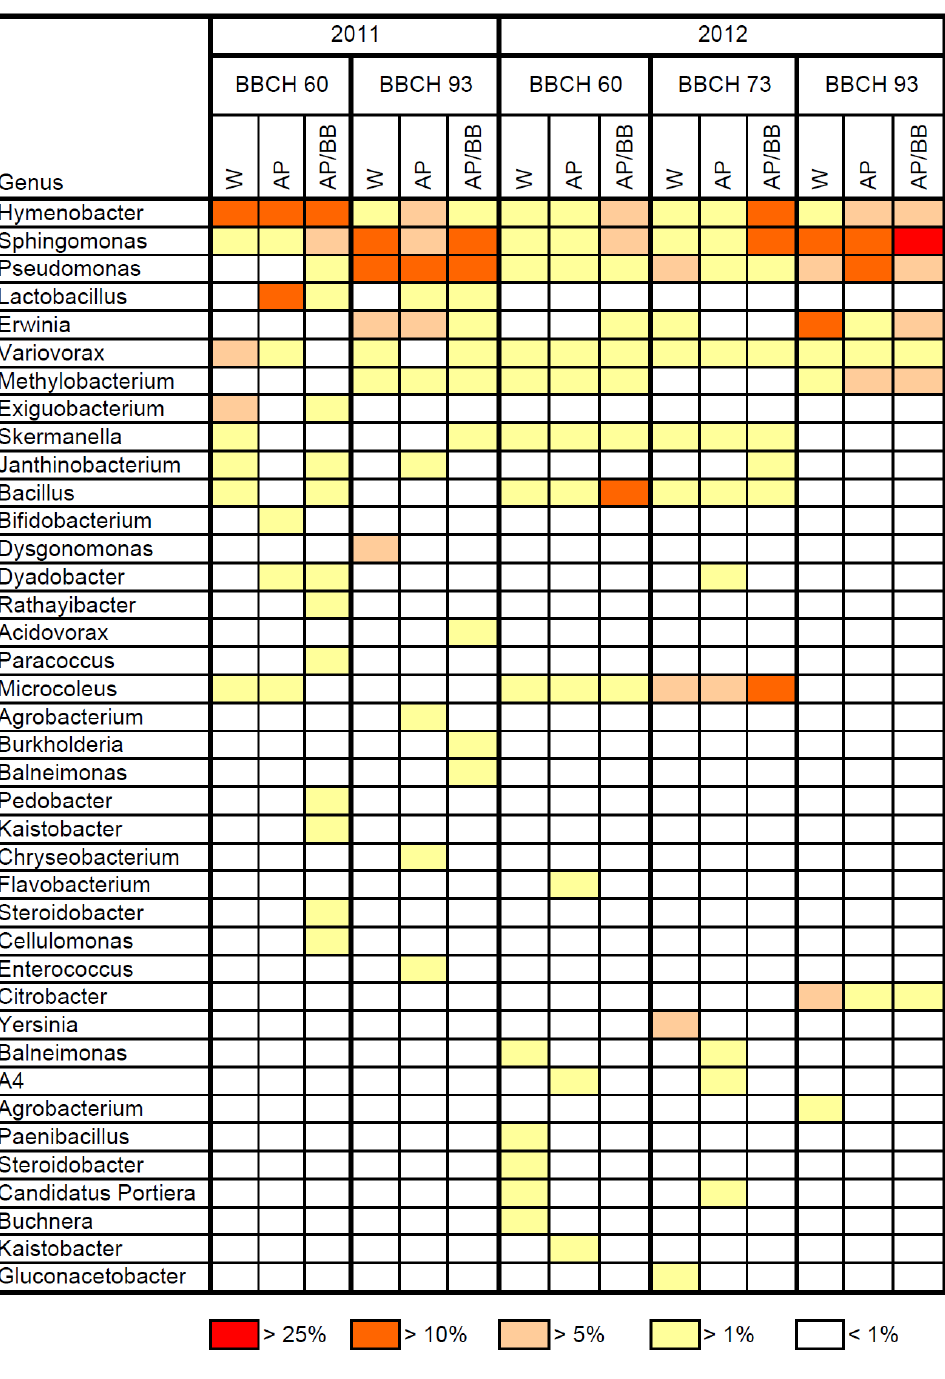
Figure 5. Most abundant bacterial genera in the strawberry phyllosphere at three distinct phenological stages (BBCH 60, BBCH 73, and BBCH 93) during two subsequent years (2011, 2012) as influenced by treatments with Aureobasidium pullulans as a single strain treatment (AP) or co-inoculated with Beauveria bassiana (AP/BB) and as determined by 454 pyrosequencing. The control (W) was treated with water from a lotic reservoir. Results from all treatments at BBCH 60 (prior to BCA applications) represent the resident bacterial community. Data for the second sampling (BBCH 73, after four BCA applications) in 2011 were insufficient and are not shown. The color legend refers to the relative abundance (% of total sequences) of bacterial